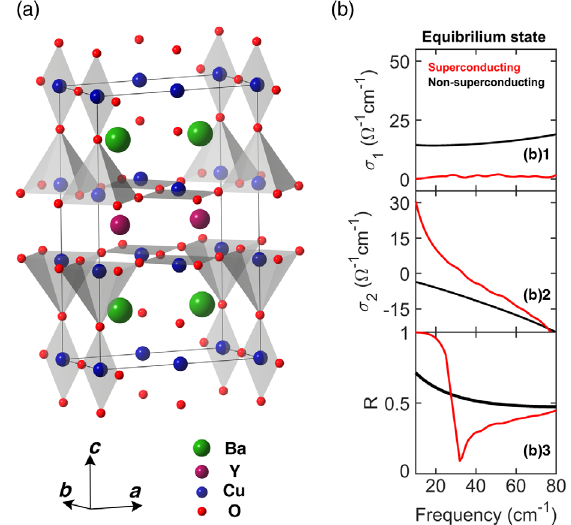
FIG. 1. Crystal structure and equilibrium terahertz optical properties of YBa 2 Cu 3 O 6 . (a) Crystallographic unit cell of . 5 orthorhombic YBa 2 Cu 3 O 6 . Bilayers of conducting CuO 2 . 5 planes, stacked along the c direction, form Josephson junctions in the superconducting state. (b) c -axis terahertz-frequency optical properties in the equilibrium superconducting ( T < T C , red curves) and normal ( T > T C , black curves) state. The real [ σ 1 ð ω Þ ] and imaginary [ σ 2 ð ω Þ ] parts of the optical conductivity are displayed along with the normal-incidence reflectivity R ð ω Þ (the same data as those reported in Refs. [1 –